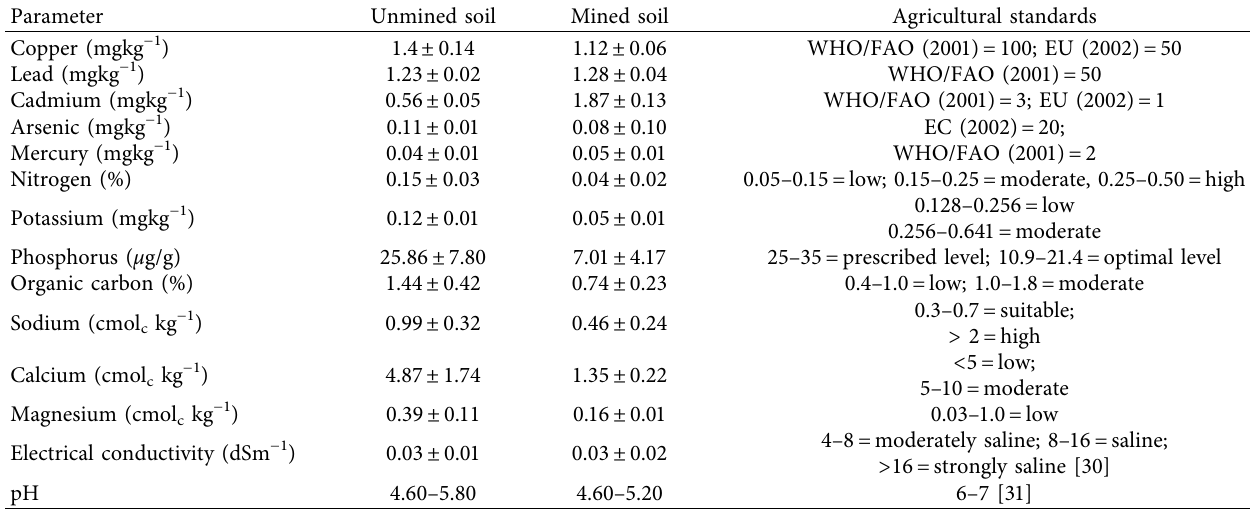
Table 3: Distribution of heavy metals and physicochemical parameters in soils of the study